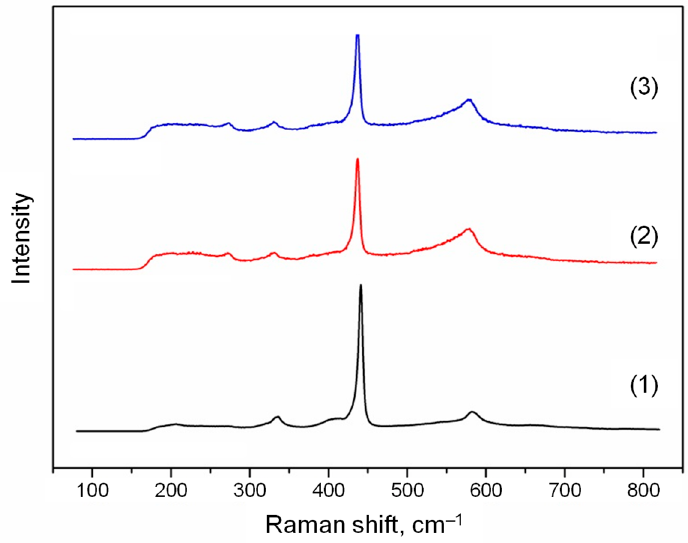
Figure 10. The Raman spectra of the ZnO structures obtained by the PECVD method at the various temperatures in the reactor deposition zone: (1) 25 °C; (2) 250 °C; (3) 350 °C.